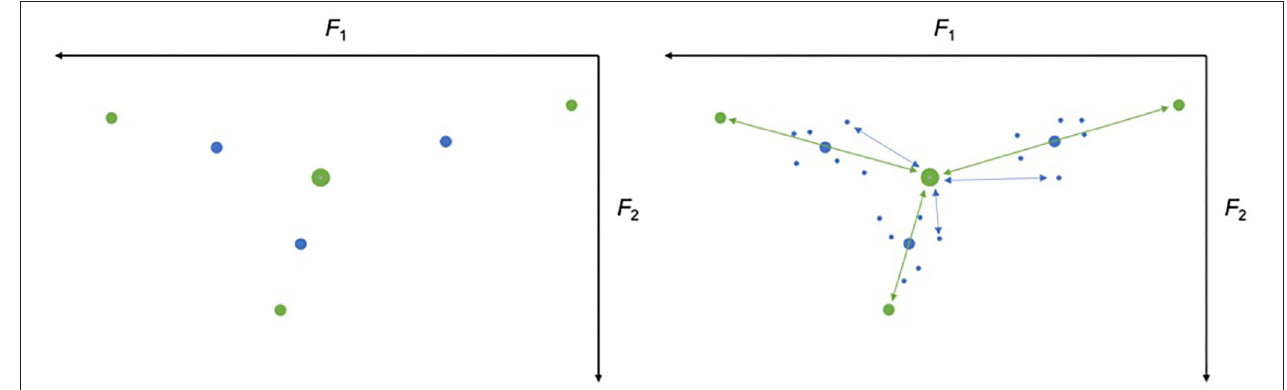
FIGURE 2 | Schematic illustration of how to calculate the vhh-index. Left: The hypoarticulation endpoint for all vowel types for a participant is the average of all vowel tokens for that participant (big green dot), the midpoint of each vowel type scale is the average of all tokens of that particular vowel type (blue dots), and the hyperarticulation endpoints are the Euclidian distances in F 1 -F 2 vowel space between the centroid and the midpoint times two (small green dots). Right: The vhh-index for each vowel token (small blue dots) is calculated as the Euclidian distance in F 1 -F 2 vowel space between the centroid and the token (blue arrows) divided by the distance between the centroid and the hyperarticulation endpoint (green